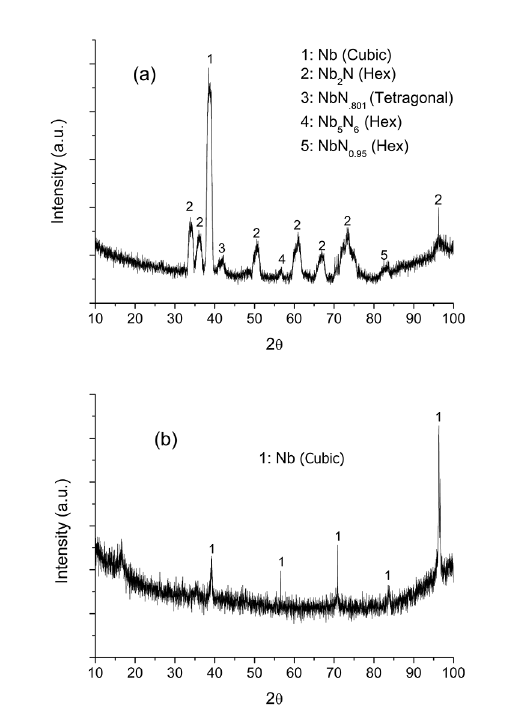
Figure 6. XRD for Nb sample heated at 1050 °C and treated via pulses of 5kV/20 μ s/300Hz, for 15 min. (a) before chemical etching, (b) after chemical etching.